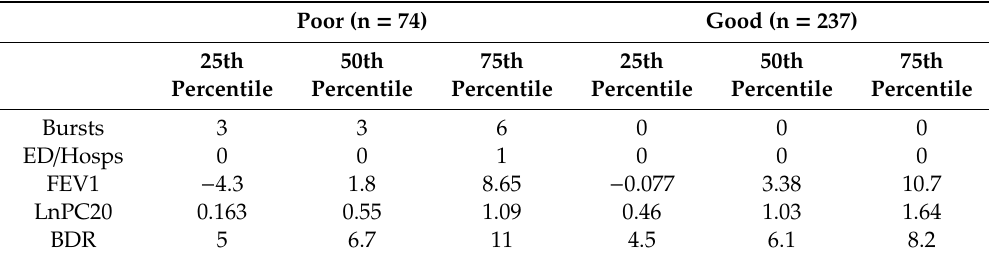
Table 2. Loadings of the first three PLS components from CAMP, with projections of the Good and Poor responder centroids into this space.